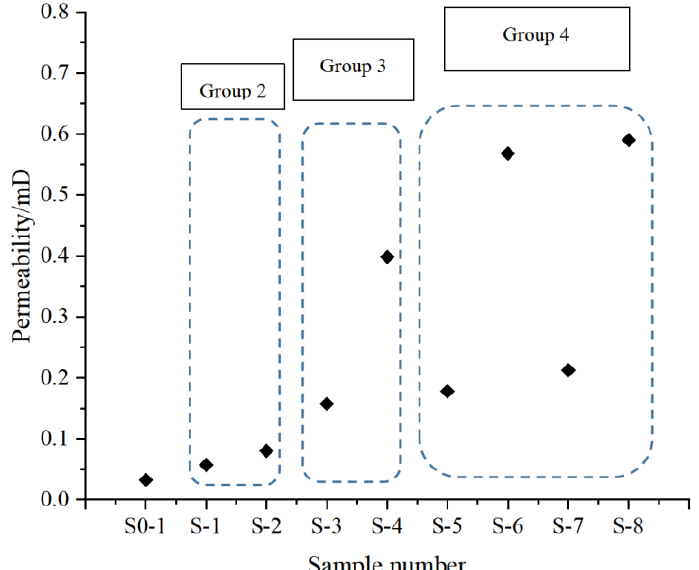
Figure 7. Permeability variation of granite under the action of different stimulation.